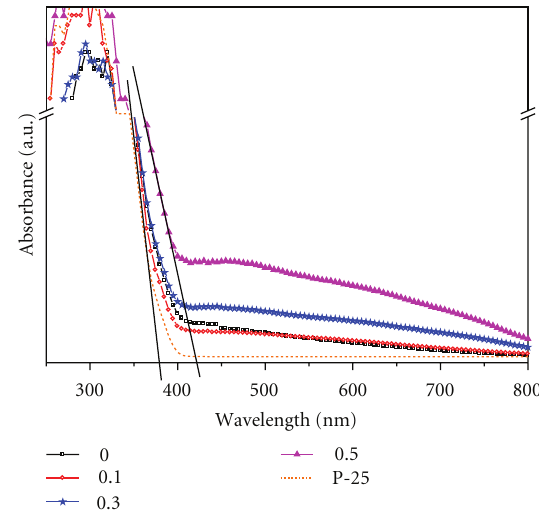
Figure 4: Optical absorption spectra of synthesized Al-doped TiO 2 and commercial P-25